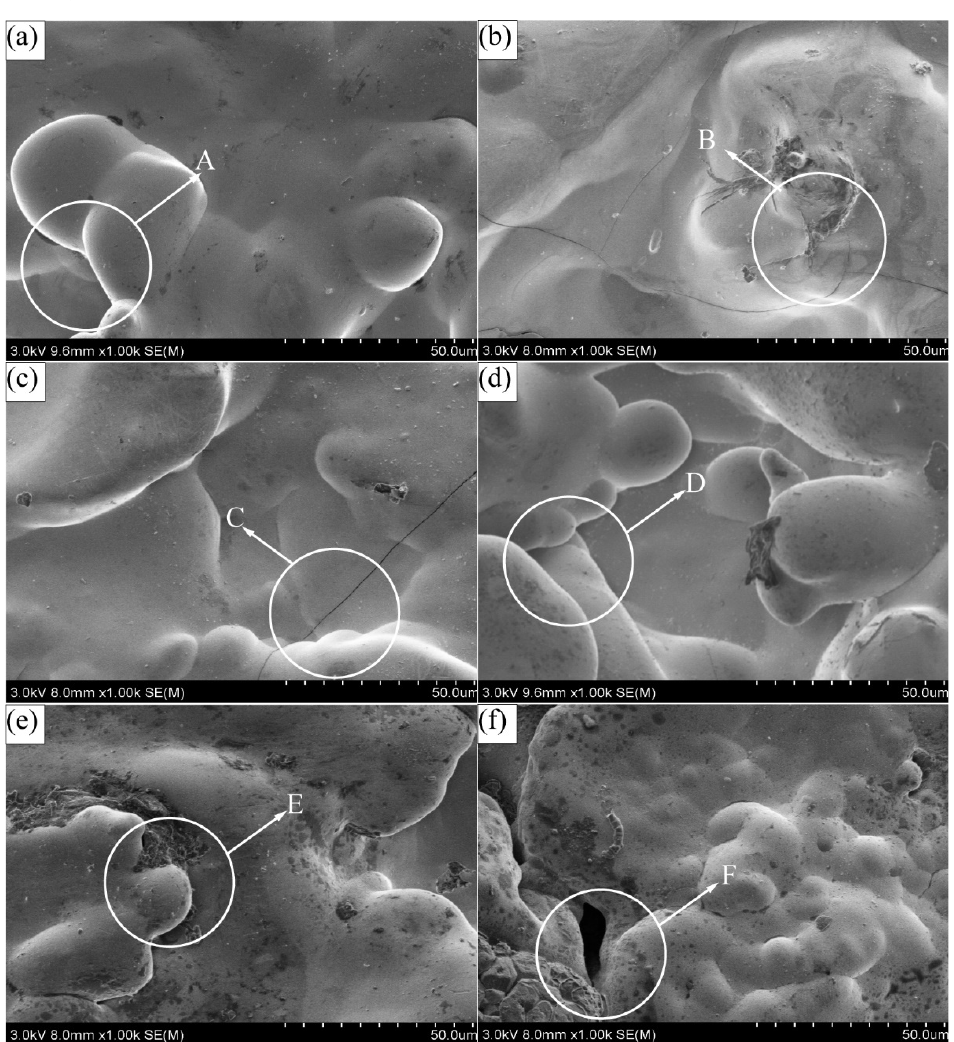
Figure 2. Surface morphologies of the composite coatings with different particle concentrations (( a ) 0, ( b ) 1, ( c ) 2, ( d ) 3, ( e ) 4, and ( f ) 5 g·L − 1 ) prepared on 45 steel substrates through scanning elec- (( a ) 0, ( b ) 1, ( c ) 2, ( d ) 3, ( e ) 4, and ( f ) 5 g · L − 1 ) prepared on 45 steel substrates through scanning trodeposition.